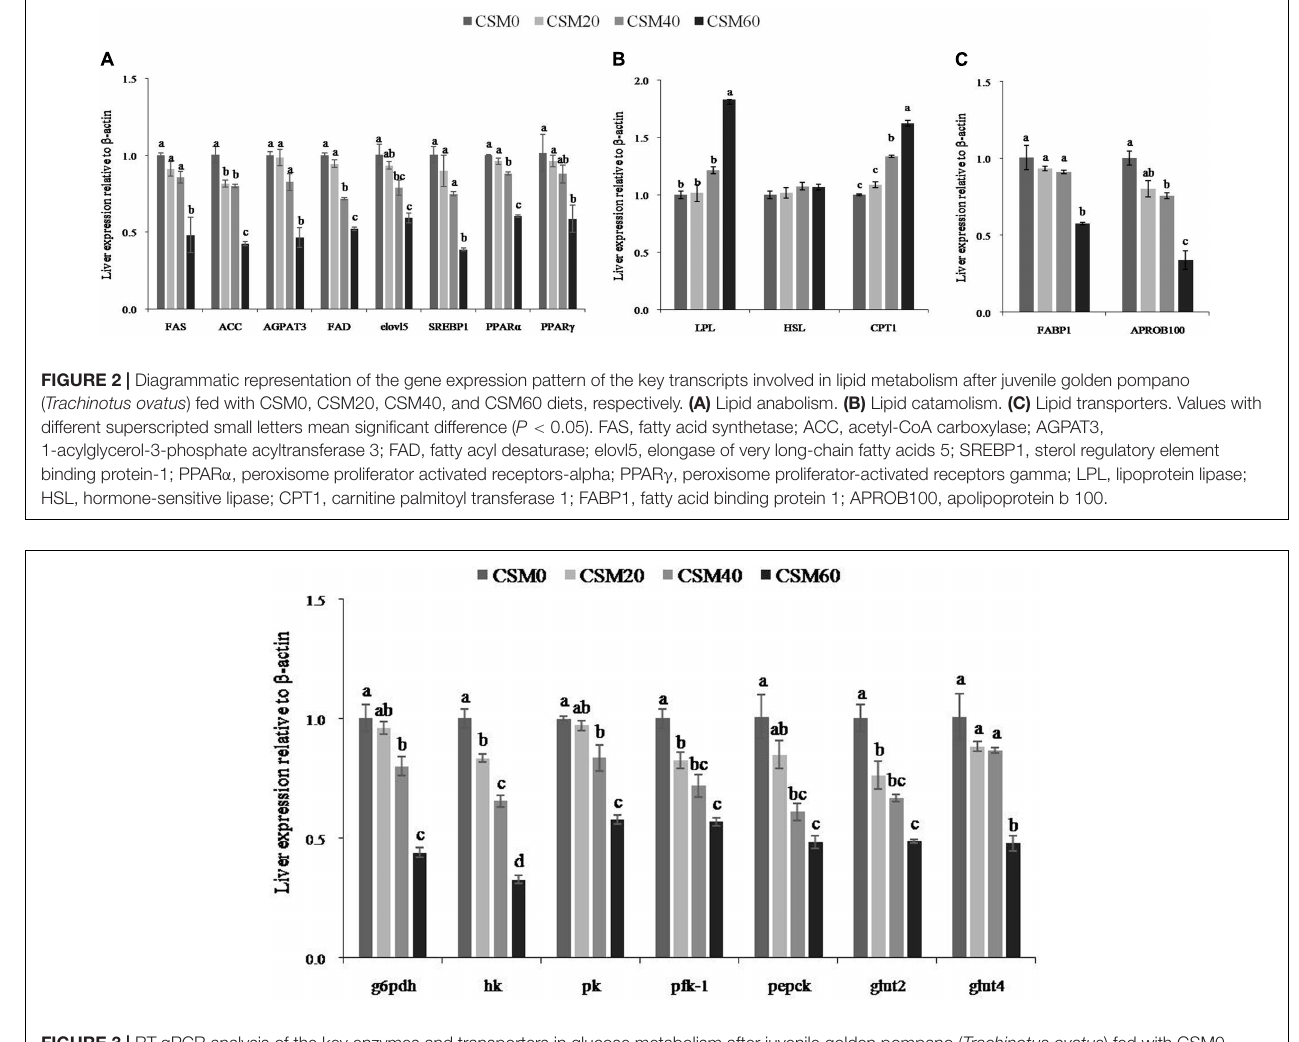
FIGURE 3 | RT-qPCR analysis of the key enzymes and transporters in glucose metabolism after juvenile golden pompano ( Trachinotus ovatus ) fed with CSM0, CSM20, CSM40, and CSM60 diets, respectively. Values with different superscripted small letters mean significant difference ( P < 0.05). g6pdh, glucose-6-phosphate; hk, hexokinase; pk, pyruvate kinase; pfk-1, phospho fructokinase-1; pepck, phosphoenolpyruvate carboxykinase; glut2, glucose transport protein 2; glut4, glucose transport protein